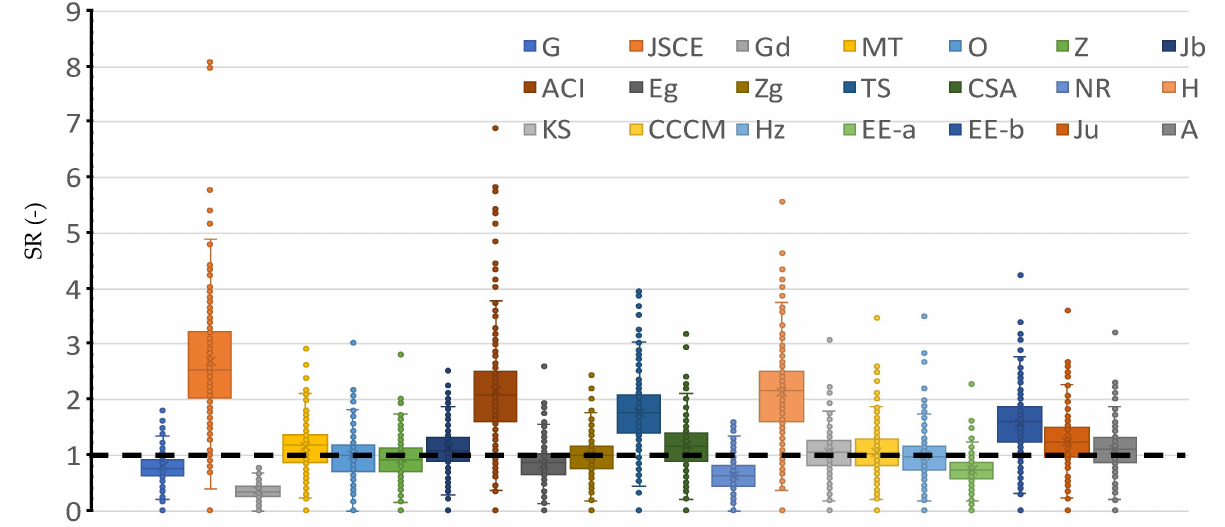
Figure 5. The performance of selected